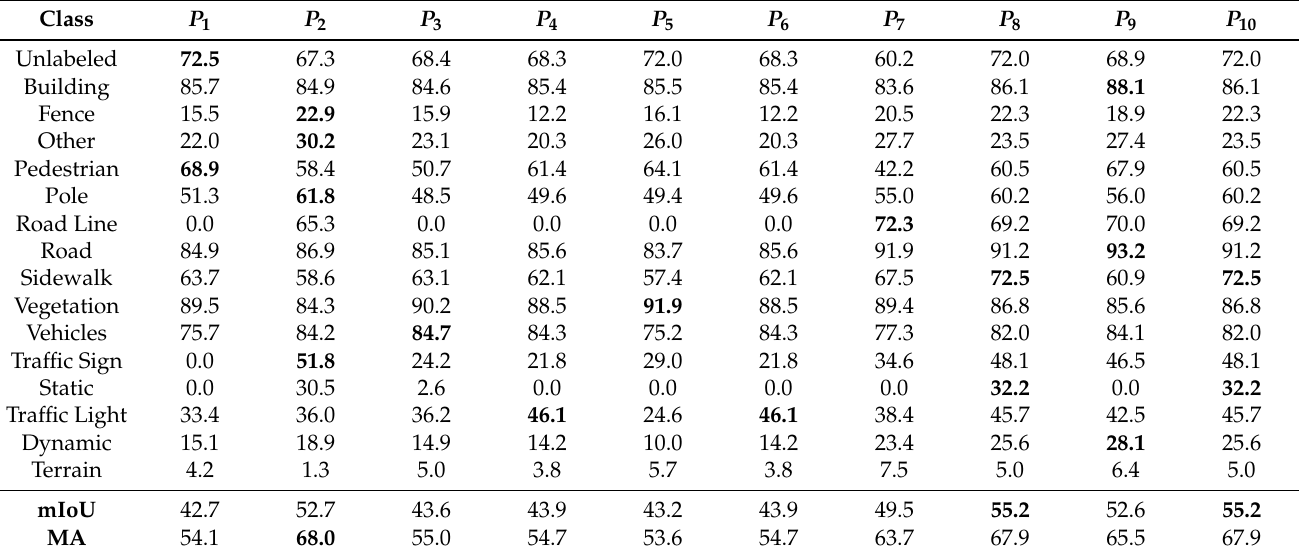
Table 5. Class-based results of RandLA-Net on subsets of Paris. Highest values are marked as